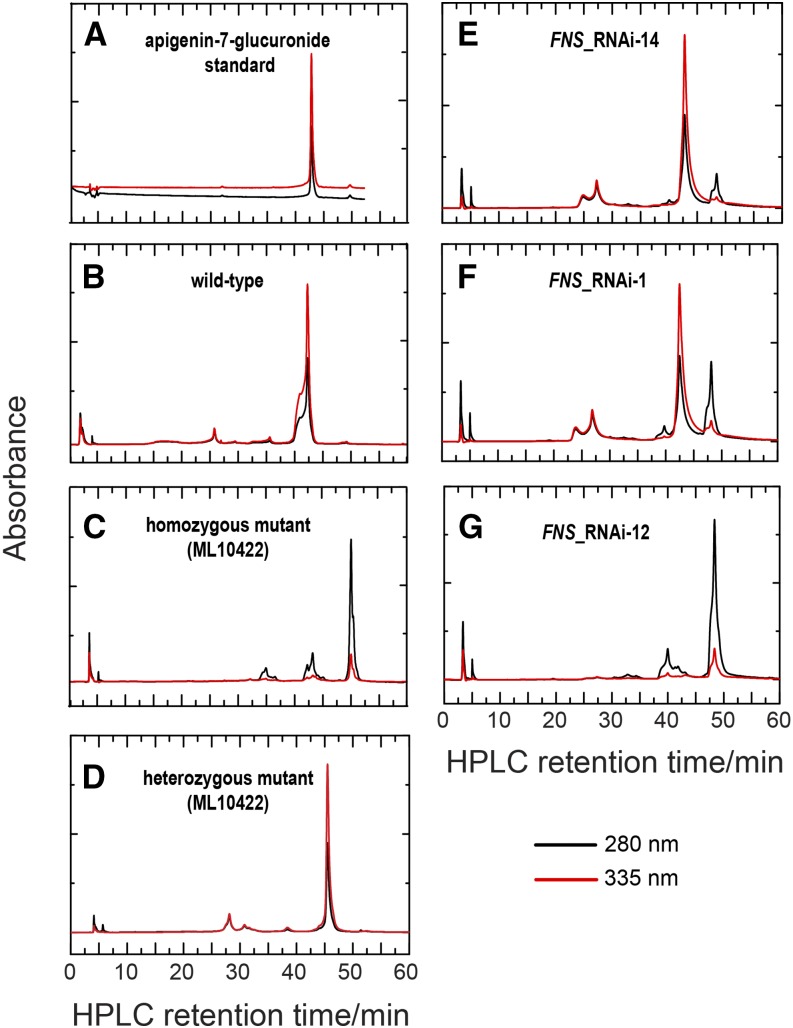
HPLC analyses. Shown are the HPLC chromatograms of the apigenin-7-glucuronide standard (A) and whole petal extracts from the wild-type LF10 (B), the homozygous (C) and heterozygous (D) mutants, and three representative RNAi lines (E–G). Red and black lines represent detection at wavelengths 335 and 280 nm, the absorption maxima that distinguish flavones and flavanones, respectively. The flavone eluted at 43 min, and flavanone at 50 min. Note that a variation of 1–2 min between runs in the retention times of the same eluting pigments is not uncommon for this HPLC protocol. HPLC, high-performance liquid chromatography; RNAi, RNA interference.